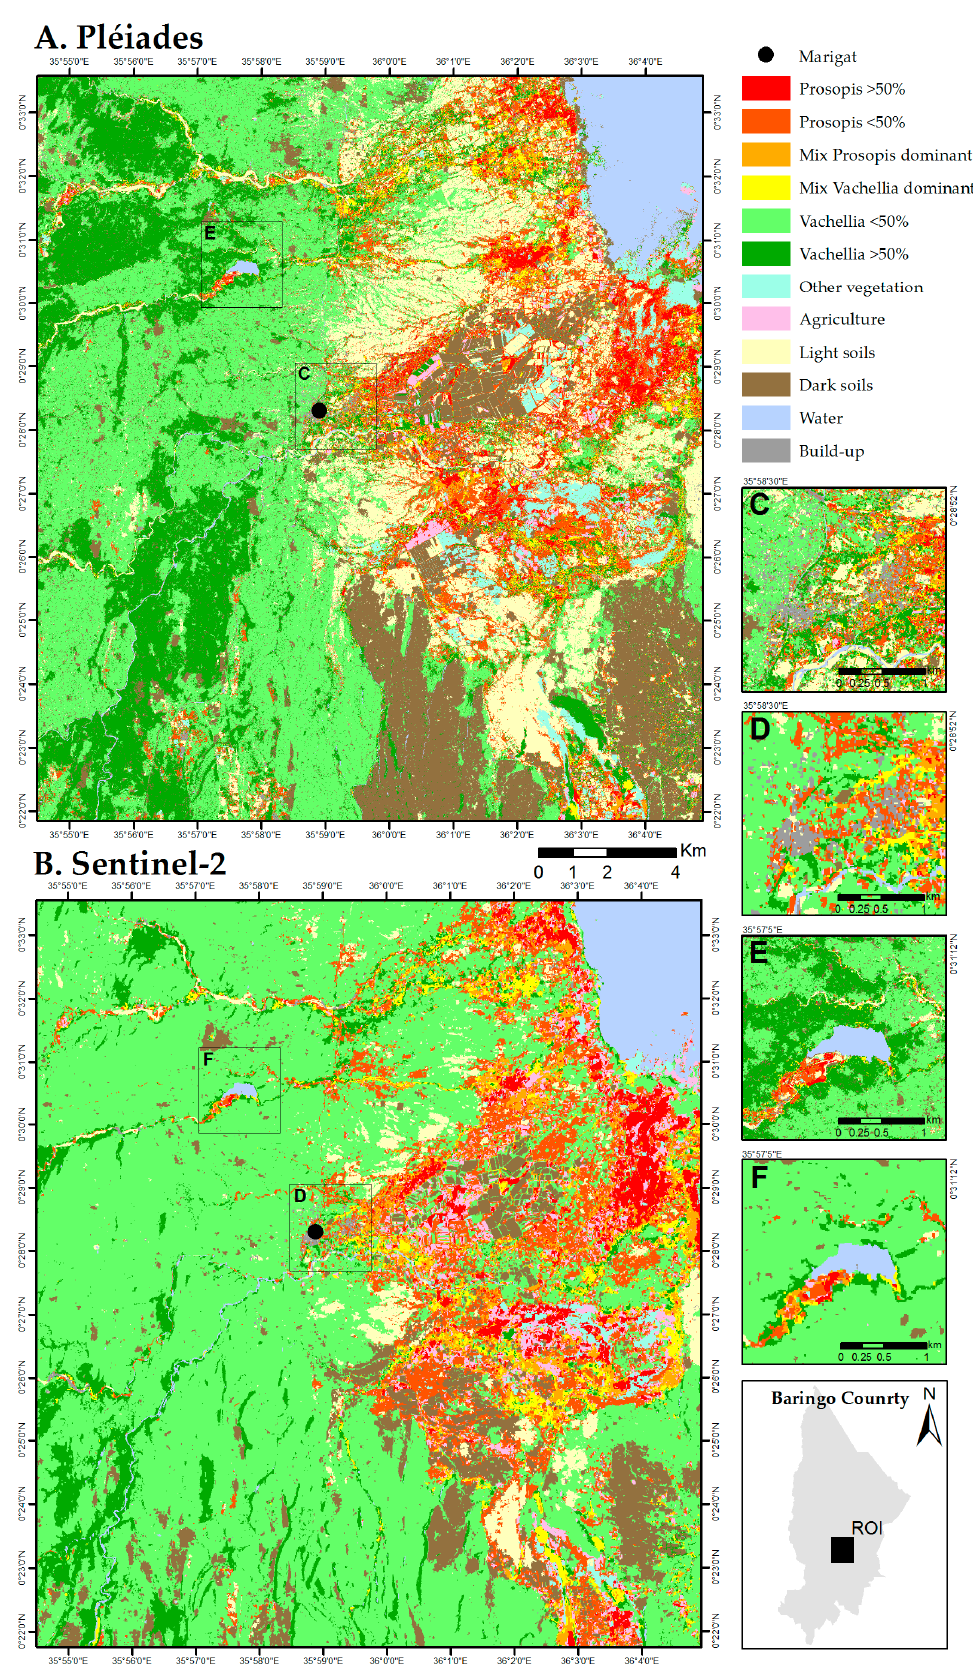
Figure 6. Results of the object-based land cover classification of the study area: ( A ) Pléiades; ( B ) Sentinel-2. Captions displayl ( C , D ) Prosopis invasion in the urban area of Marigat; and ( E , F ) Prosopis invading a small waterbody.